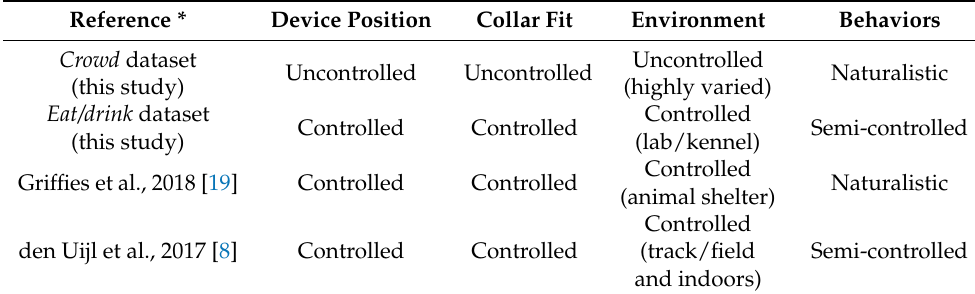
Table 10. Dataset collection methods in similar published